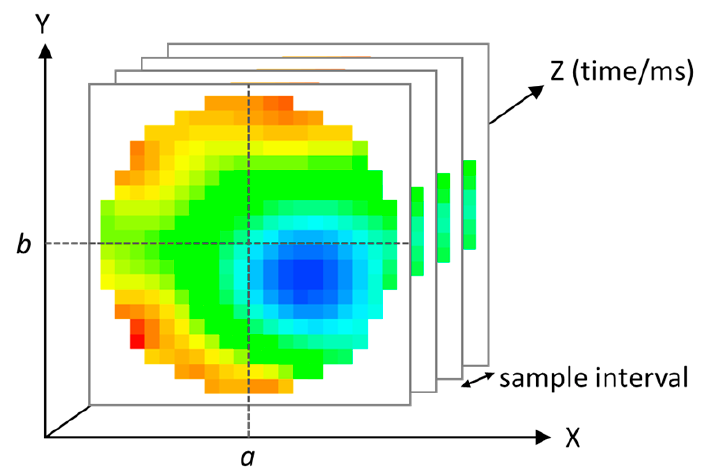
Figure 7. ERT concentration tomograms stacked by time-series.